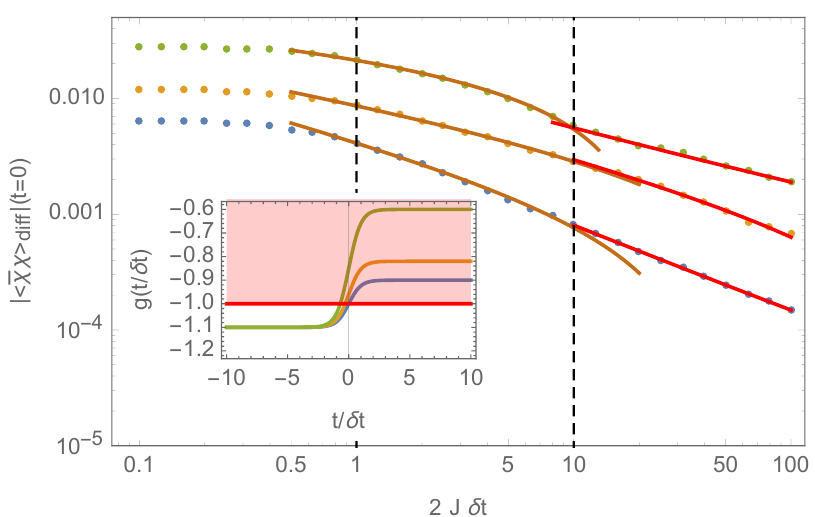
Figure 6 . Plot of h (cid:22) (cid:31)(cid:31) i di(cid:11) as a function of 2 J(cid:14)t for the gapped-to-gapless quenches shown in the inset. The brown and red curves are the best (cid:12)ts in the fast and slow quench regimes, respectively. As an example, we show here the transition between 3 di(cid:11)erent scalings. In the inset, the three quenches protocols are shown. All of them start at a distance of 0.1 from the critical region. The blue protocol goes to the edge at t = 0, g ( t=(cid:14)t ) = (cid:0) 1+0 : 1 tanh( t=(cid:14)t ); the yellow protocol, just enters the critical region at t = 0, g ( t=(cid:14)t ) = (cid:0) 0 : 96 + 0 : 14 tanh( t=(cid:14)t ); and the green protocol is well inside the critical area at t = 0 (compared to the initial amplitude), g ( t=(cid:14)t ) = (cid:0) 0 : 85 + 0 : 25 tanh( t=(cid:14)t ). As in the previous subsection, the scalings of the blue dots correspond to the gapped-to-edge quench: in the fast regime it goes as P + Q (2 J(cid:14)t ) (cid:0) 1 = 2 (brown curve) with P = (cid:0) 0 : 00482 and Q = 0 : 000750; in the slow regime, it behaves as P + Q (2 J(cid:14)t ) (cid:0) 3 = 4 (red curve) with P = (cid:0) 0 : 00448 and Q = (cid:0) 6 : 97 (cid:2) 10 (cid:0) 6 . Now, when you measure inside the critical area, the slow scaling changes instantaneously to (cid:0) 1 = 2, while the fast quench continually changes from (cid:0) 1 = 2 to a logarithmic scaling. Thus, the two regimes in the yellow quench are given by P + Q (2 J(cid:14)t ) (cid:0) (cid:11) (brown, fast),